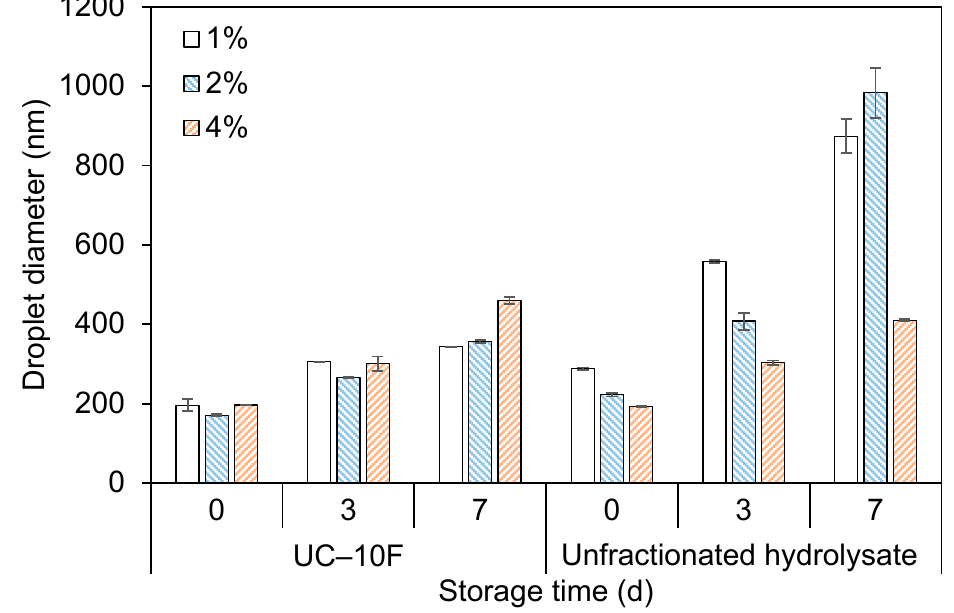
Figure 6. Influence of ultrafiltration on nanoemulsion stability stored at 25 °C for 7 d. Emulsifier types included UC–10F chymotrypsin WPI fraction and unfractionated chymotrypsin WPI hydrolysate, at varying concentrations (1–4%). Data for unfractionated chymotrypsin WPI hydrolysate were from Adjonu et al. [1].